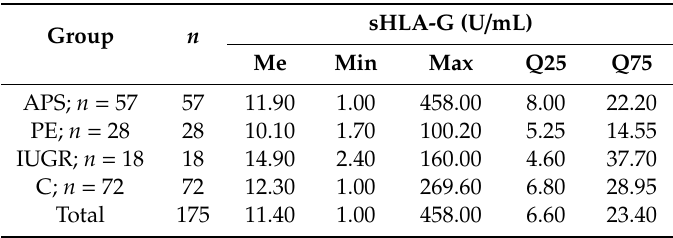
Table 2. Median (Me), minimum (min), and maximum (max) serum sHLA-G levels (U / mL) in the women with antiphospholipid syndrome (APS), preeclampsia (PE), intrauterine growth restriction (IUGR), and in the control group (C). Results are from Mann–Whitney U tests.